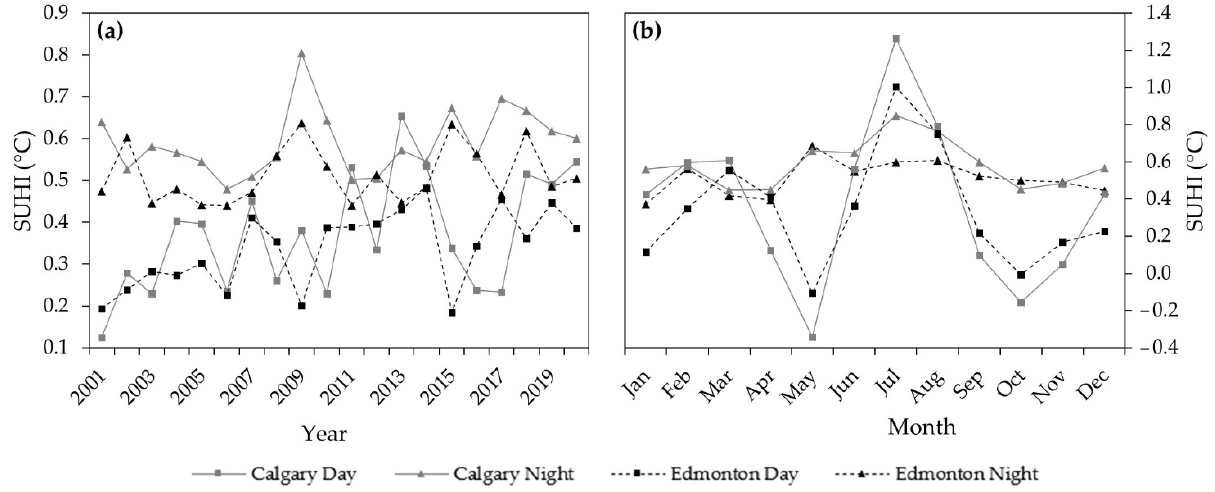
Figure 3. Annual day and nighttime SUHI ( a ); and monthly day and nighttime SUHI ( b ) at the cities of Calgary and Edmonton over the period 2001 ‒ 2020.